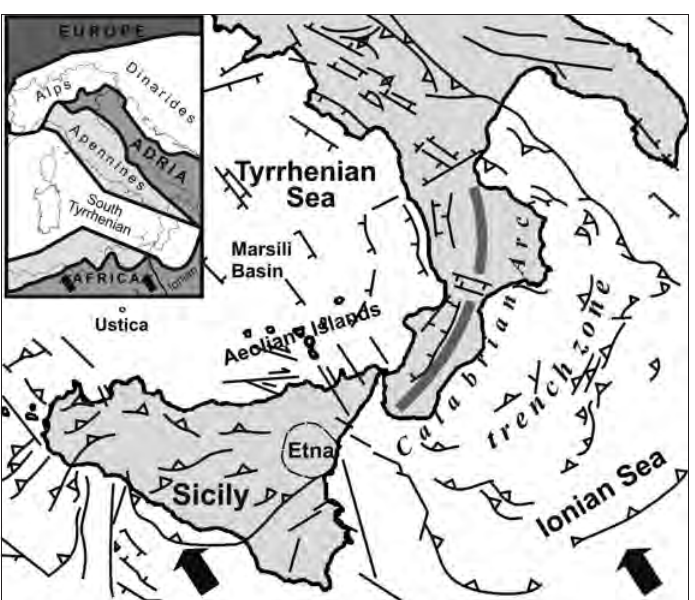
Fig. 1. Structural map of Southern Italy, from Meletti et al. (2000) and Neri et al. (2005). In agreement with stan- dard symbols, barbs indicate the downthrown blocks in normal faults, fault arrows show the strike-slip component of the fault mechanism, triangles indicate the sense of dipping of thrust structures. The shaded belt indicates the lo- cation of the Apennine chain in the Calabrian Arc. The arrows indicate the motion direction of Africa with respect to Europe as predicted by large-scale crustal motion models (Sella et al. , 2002; Calais et al. , 2003; Nocquet and Calais, 2004). NW-SE plate convergence is considered the main tectonic engine in the study region acting togeth- er with gravity-induced southeastward roll-back of the Ionian lithosphere subducting beneath the Tyrrhenian Sea ( e.g. , Faccenna et al. , 2001b). The inset displays a map of the Italian region showing the main tectonic units and microplates identified between the Africa and Europe stable margins (Scandone and Stucchi,